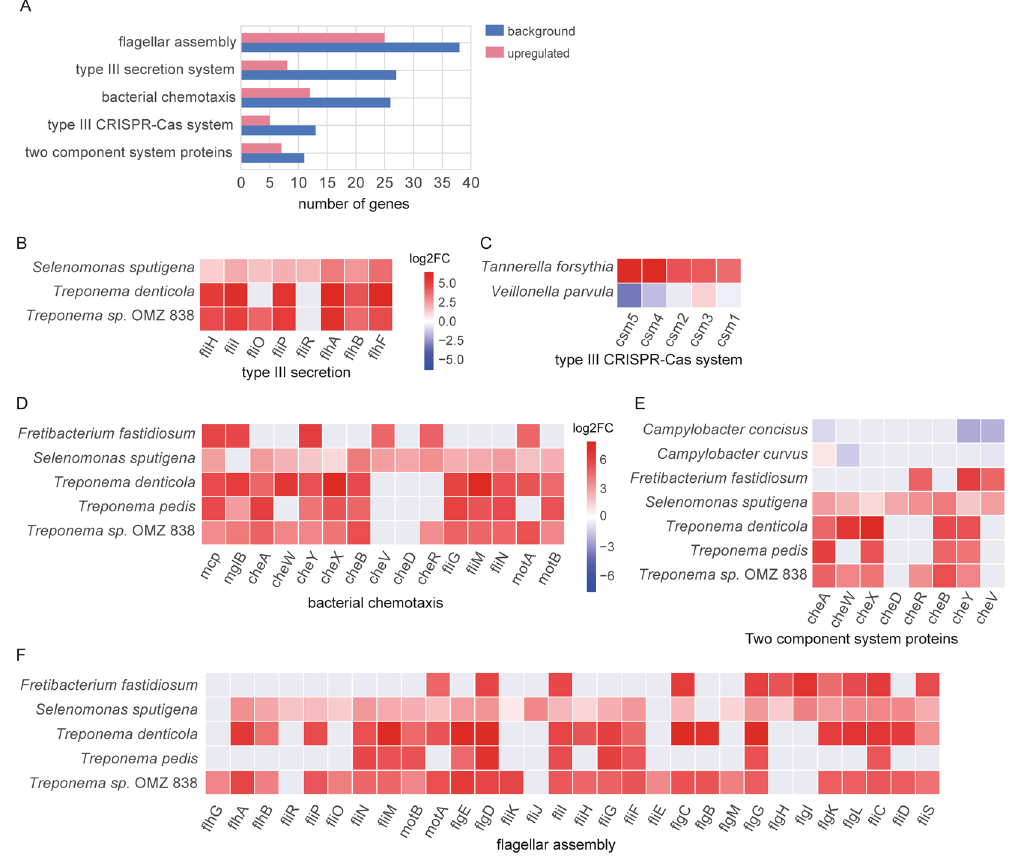
Figure 3. KEGG pathways and functional modules enriched in periodontitis and key microbial players driving the shifts. ( A ) Enrichment of the five most strongly up-regulated KEGG modules in periodontitis. The red bars indicate the number of up-regulated KEGG orthologous gene in the gene set, while dark blue bars show the number of total expressed genes of a given pathway or module. Only the enriched gene sets with FDR < 0.1 and (number of up-regulated genes)/(number of expressed) > 25% are shown here. The complete list of all enriched pathways and modules can be found in Table 1. ( B – F ). Key microbial players driving the up-regulation of those functional pathways. Pathways consist of several KO genes (Supplementary Table 3), each of which contains several species specific genes. Only species specific genes with expression level count per million reads (CPM) ≥ 10 are shown. The horizontal axis shows the KEGG orthology genes in the pathway and vertical axis shows the microorganisms in which these KO genes were up- or down-regulated. Note different scales for B , C and D – F